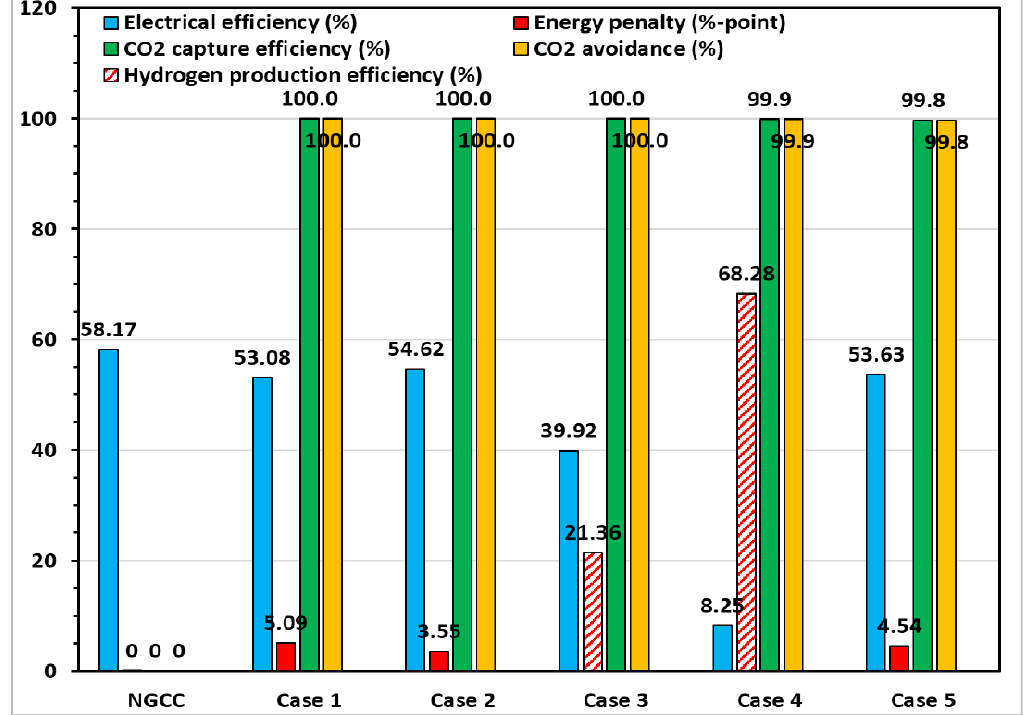
ff erent plant integration